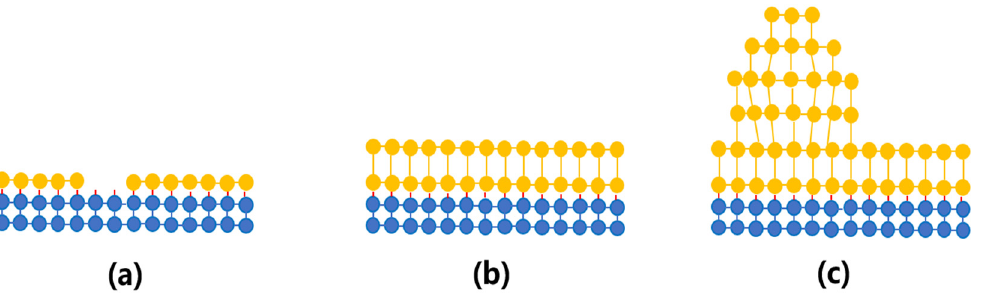
Figure 7. Schematic of SK growth. ( a ) Original molecule deposition. ( b ) Wetting layer formation. ( c ) QD formation and strain relaxation. The atoms of substrate and epitaxial layer were represented with blue and yellow, respectively.